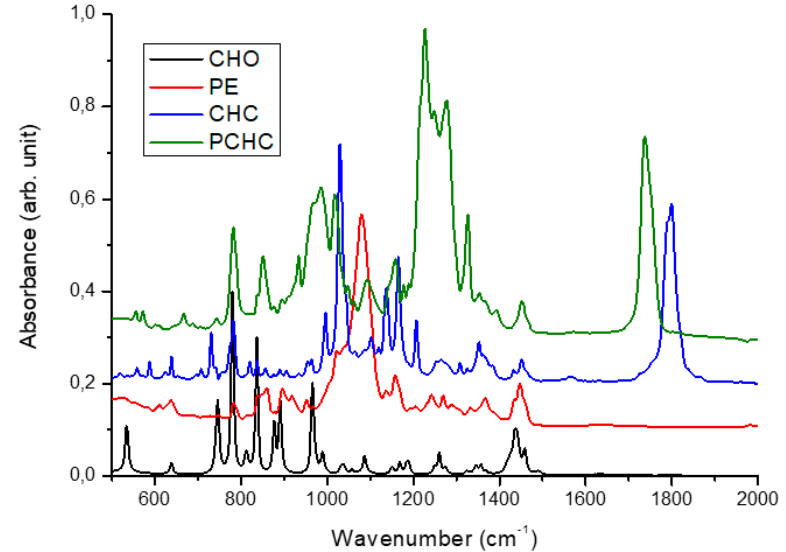
Figure 1. ATR-IR spectra of cyclohexene oxide (CHO), cyclic cyclohexene carbonate (CHC), poly(cyclohexene carbonate) (PCHC), and poly(cyclohexene ether) (PE).